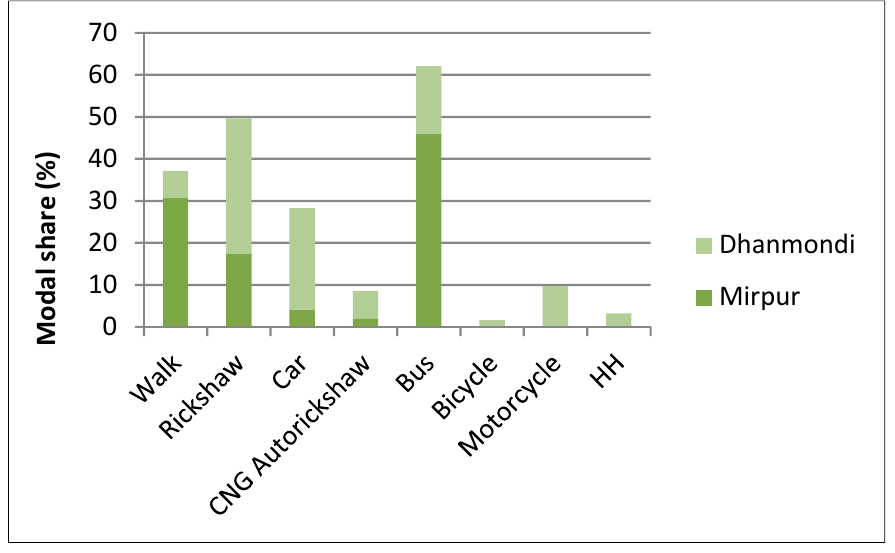
Figure 3. Area-wise modal share of respondents for all trips. HH: household. CNG: compressed natural gas .